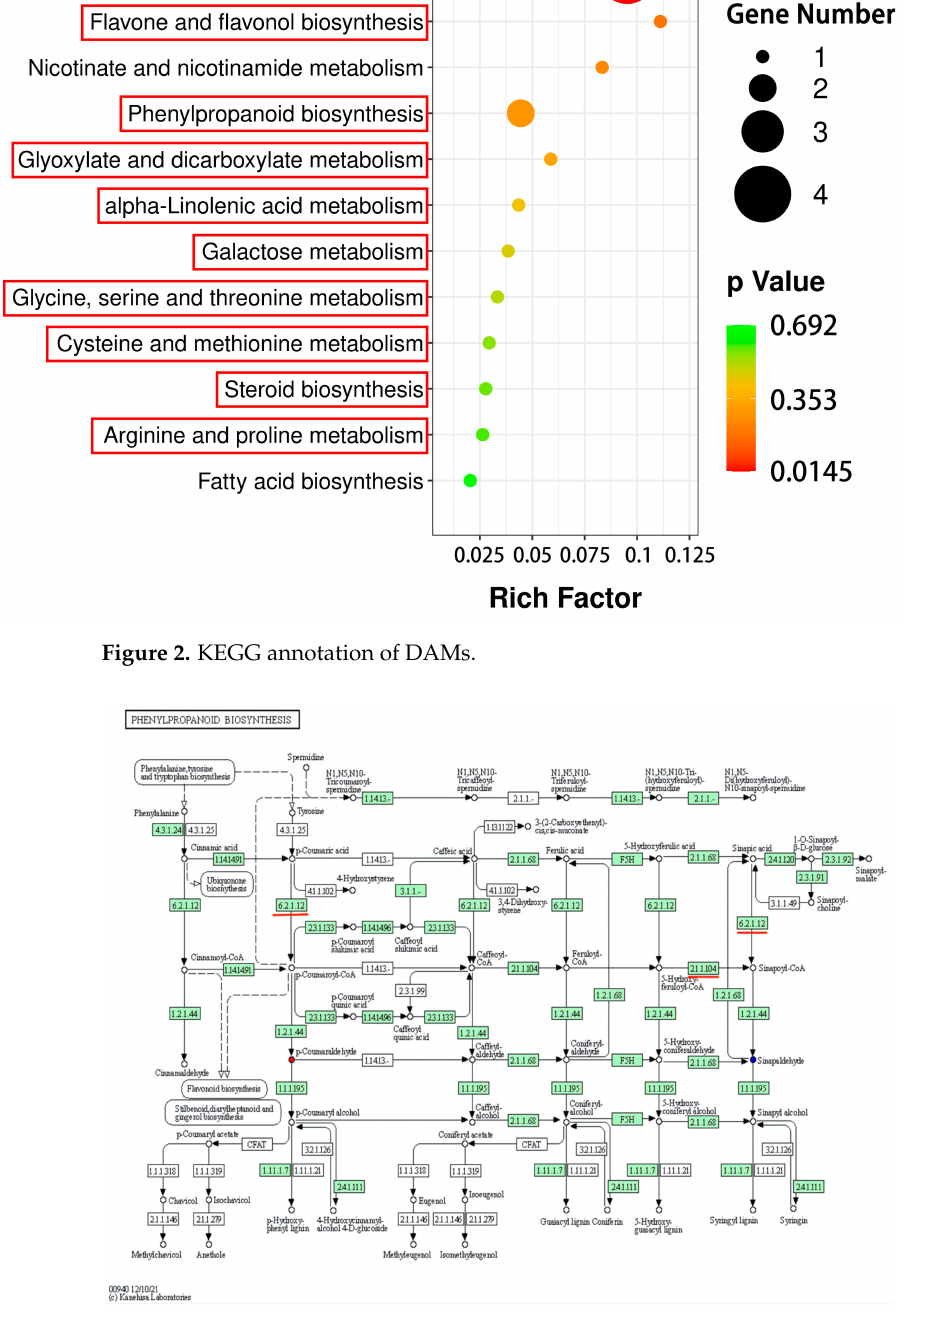
Figure 3. DAM-annotated phenylpropanoid biosynthesis. Red circle: up-regulated DAM. Blue circle: down-regulated DAM. White circle: unchanged metabolite. Arrow: metabolic reaction direction. The number in every box is composed of 4 numbers: EC number. EC numbers in the boxes with green background: enzymes included in R. glutinosa . EC numbers in the boxes with white background: enzymes not included in R. glutinosa . The numbers underlined in red: the same enzymes as shown in Figure